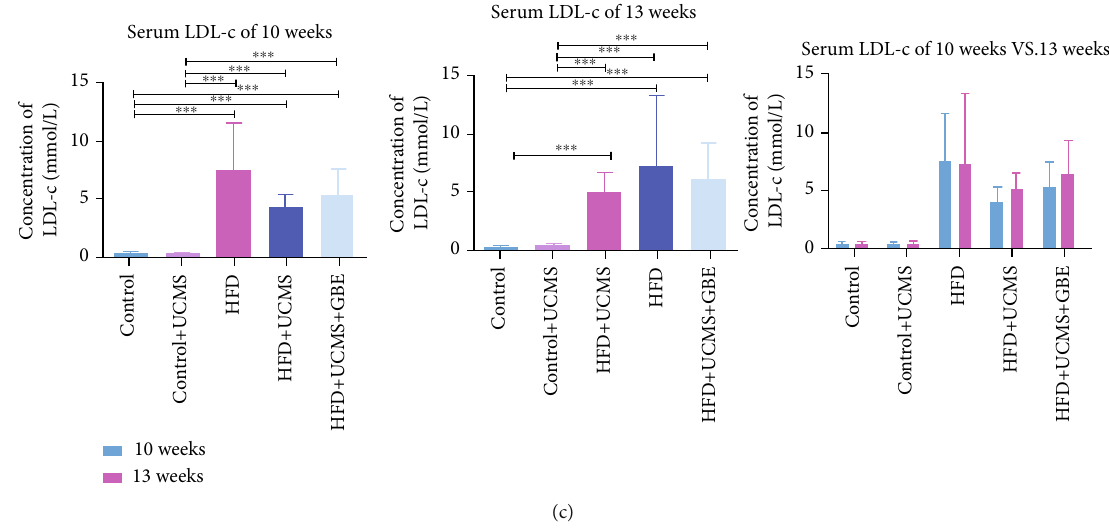
Figure 1: Lipid metabolism alterations. (a) The body weight of rats in di ff erent groups; (b, c) TCHO and LDL-C comparisons among the fi ve groups in the 10th or 13th week. TCHO: total cholesterol; LDL-C: low density lipoprotein cholesterol; n = 5 rats per group; ∗ P < 0 : 05 ; ∗∗ P < 0 : 01 ; ∗∗∗ P < 0 : 001